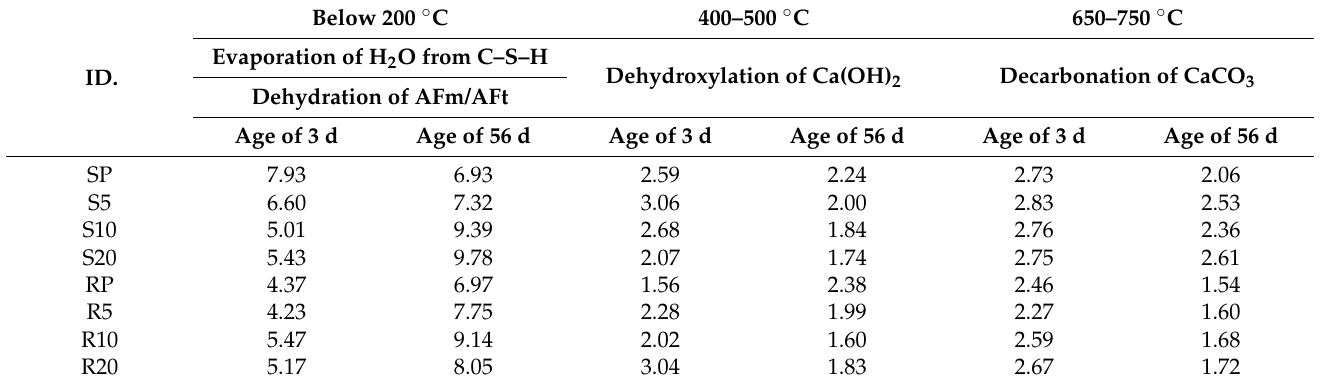
Table 5. Weight loss of specimens by temperature range